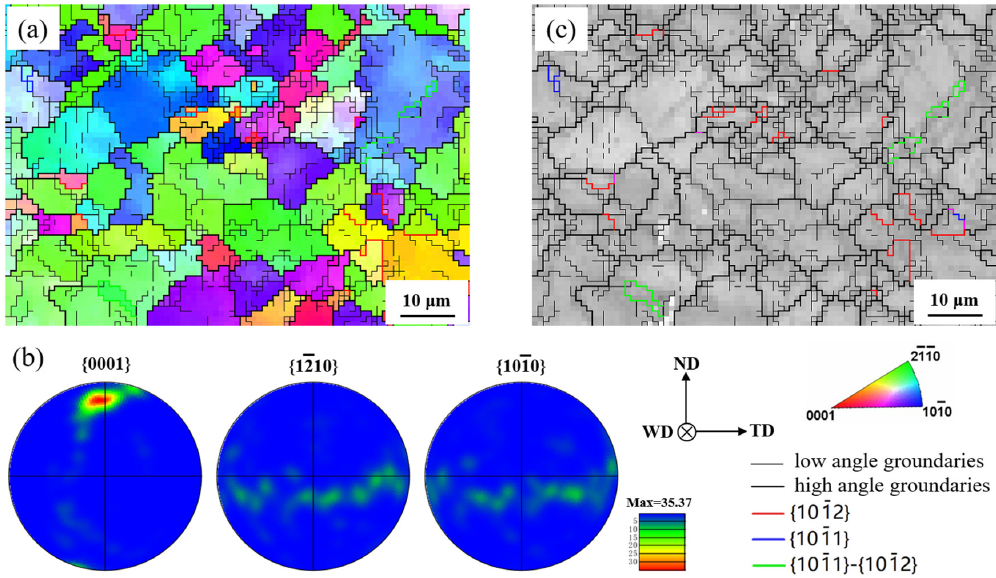
Figure 8. EBSD orientation maps of the micro-region in the right end of twin band: ( a ) IPF map, ( b ) pole figures and ( c ) grain boundary map. figures and ( c ) grain boundary